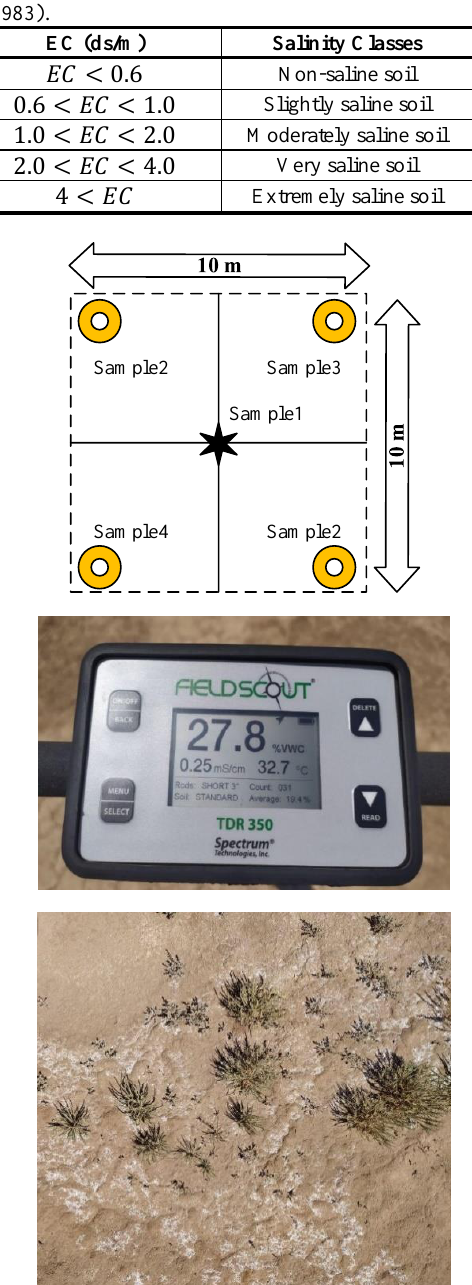
Figure 2. In-situ data collection tool and a sample photo from the landscape of the study area.